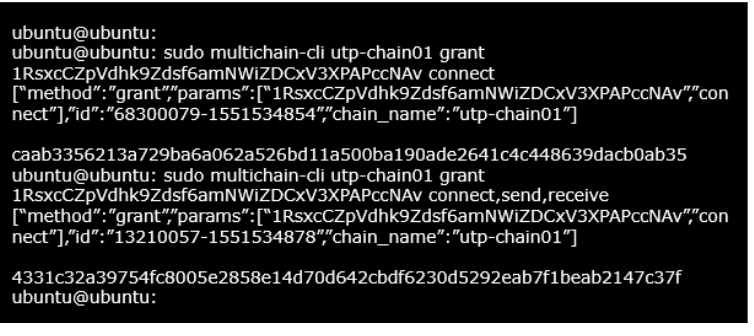
Figure 13. New node joined into IoT blockchain.